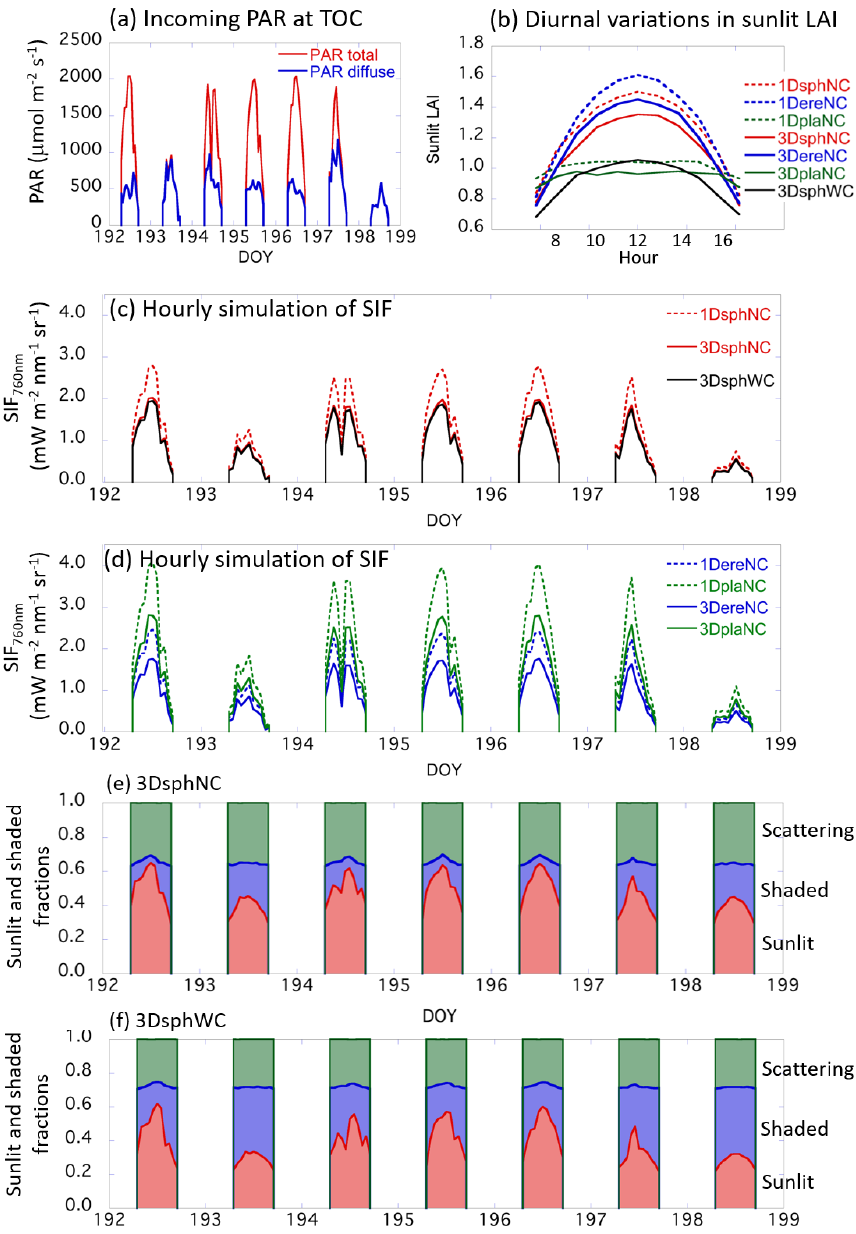
Figure 19. Summary of the diurnal SIF variations with actual incident PAR data. (a) Incoming total and diffuse PAR at the top of canopy (TOC). The observed PAR data in photon units (µmolm − 2 s − 1 ) are converted to the unit of energy unit (Wm − 2 ) for the SIF simulation. (b) Diurnal variations in sunlit LAI for different canopy structures. In all scenarios, total LAIs were set to 3. (c) Simulated SIF radiances on hourly timescales for 1DsphNC, 3DsphNC, and 3DsphWC. (d) Simulated SIF radiances on hourly timescales for 1DereNC, 1DplaNC, 3DereNC, and 3DplaNC. Dotted lines are 1-D scenarios and solid lines are the results of 3-D scenarios. (e) The fraction of sunlit, shaded, and scattering contributions in the simulated total SIF radiance for 3DsphNC (no clumping). (f) The fraction of sunlit, shaded, and scattering contributions in the simulated total SIF radiance for 3DsphWC (within-crown